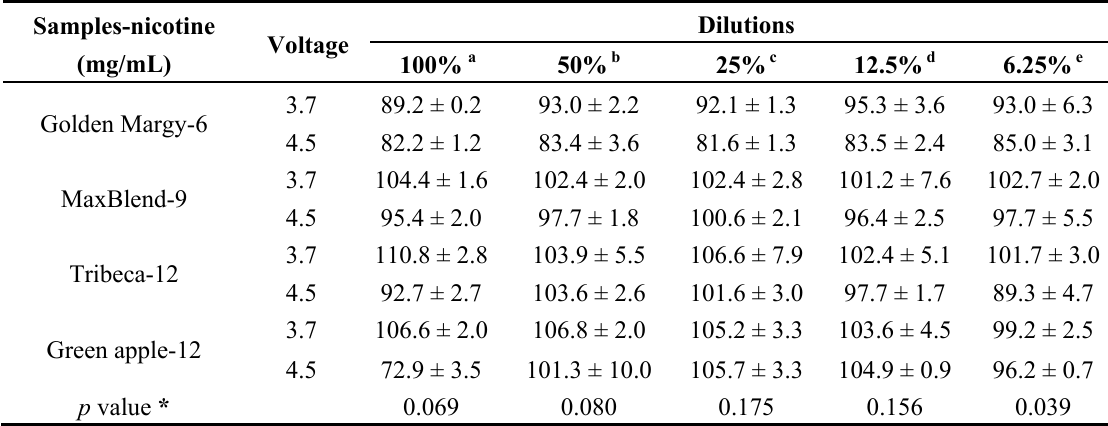
Table 3. Comparison of myocardial cell viability between regular and high voltage-produced electronic cigarette vapour